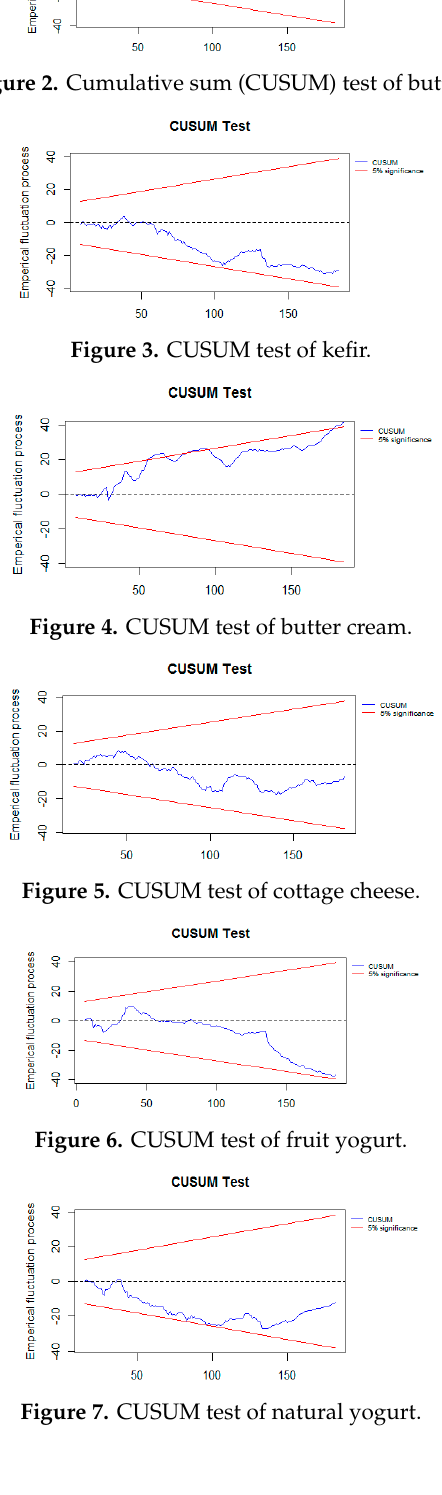
Figure 7. CUSUM test of natural yogurt.